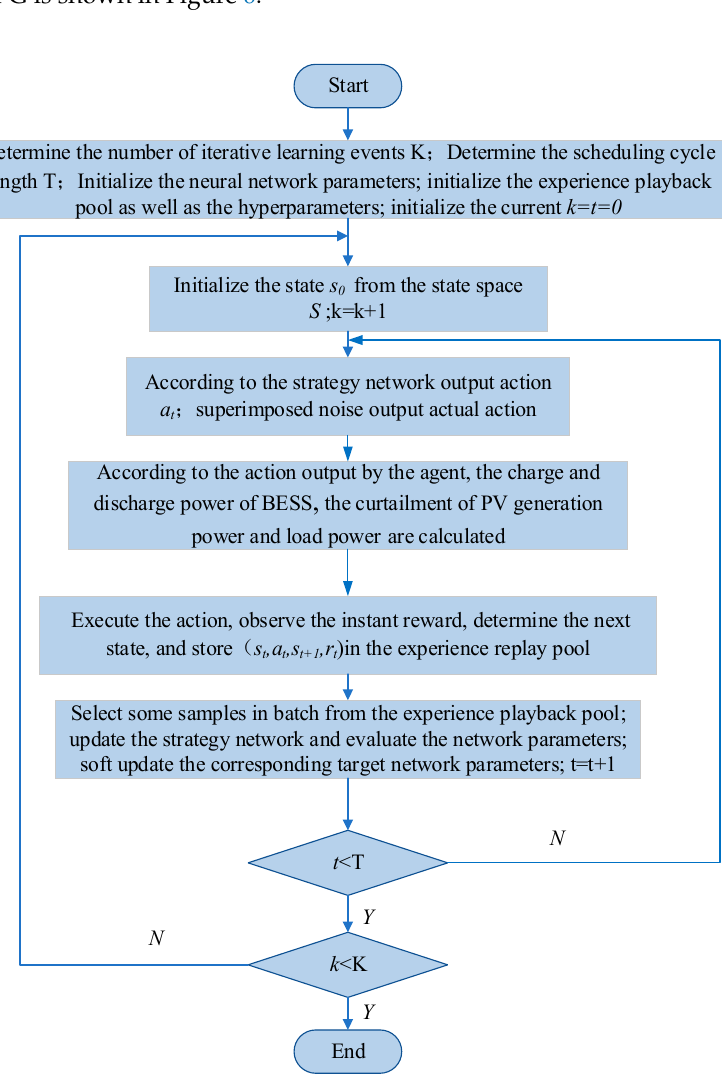
Figure 6. The flowchart of optimal operation of microgrid.